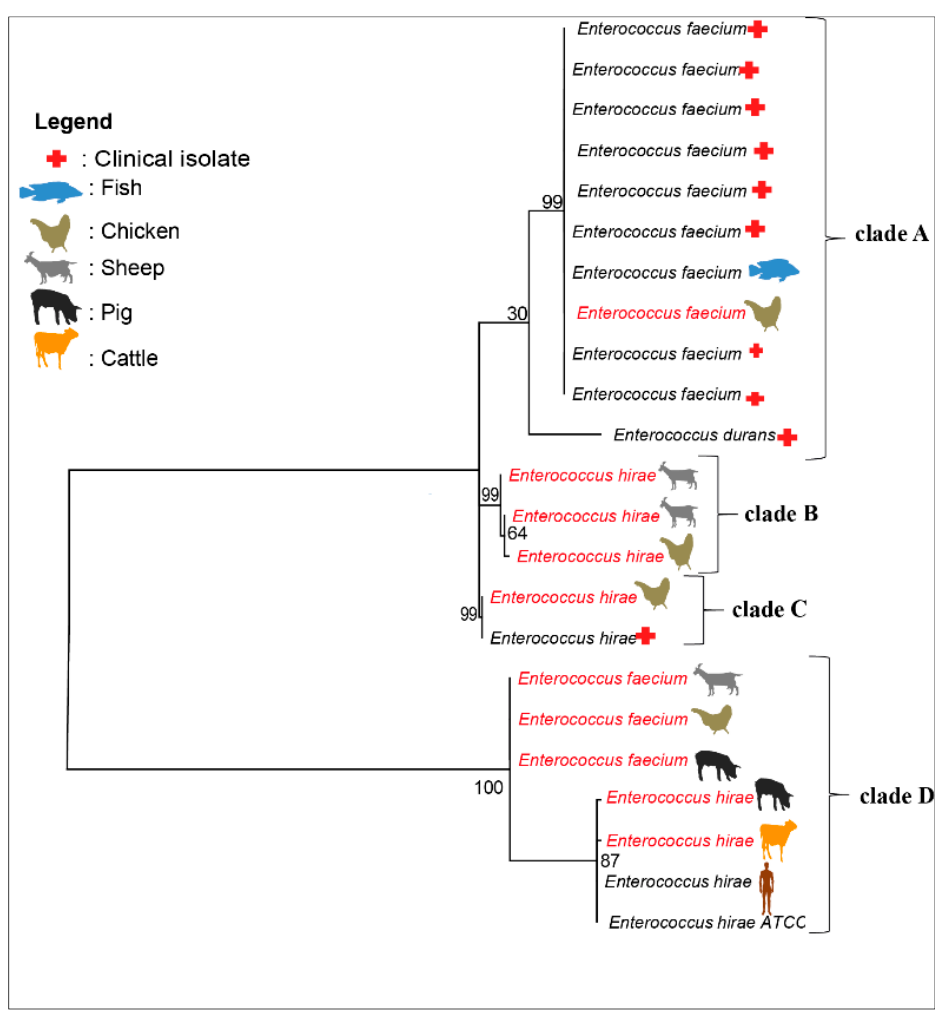
Figure 1. Phylogenetic analysis of E. faecium and E. hirae . The phylogenetic tree was constructed by a sequence homology of the sodA gene between four E. faecium and six E. hirae isolates randomly (black) selected from our study and those in from the NCBI database (red).